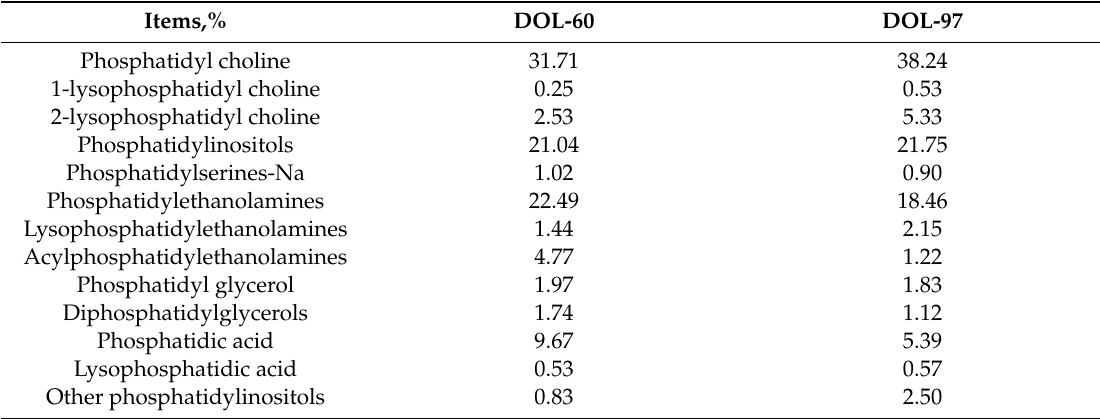
Table 1. Phospholipid composition of DOL-60 and DOL-97.